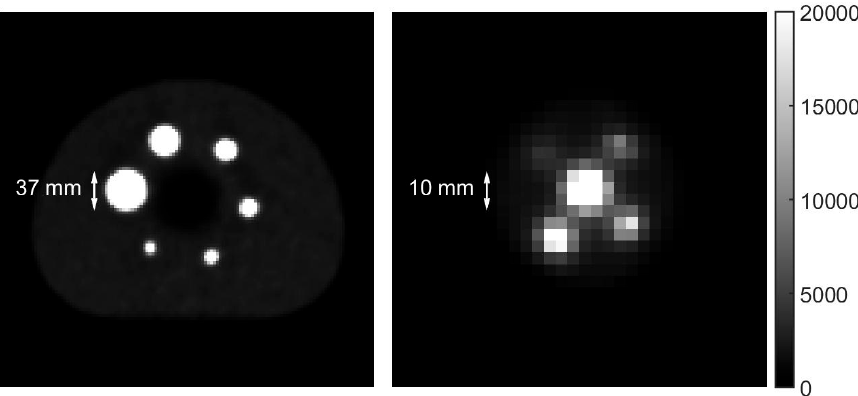
Figure 1. Transverse PET slices of the NEMA IEC Image Quality phantom ( left ) and the Micro Hollow Sphere phantom ( right ). The image of the Micro Hollow Sphere phantom is scaled up by a factor four with respect to that of the NEMA IEC Image Quality phantom to properly show the features. The dimensions of the largest sphere in the Micro Hollow Sphere phantom match with those of the smallest sphere in the NEMA IEC Image Quality phantom. As the voxel dimensions in the transverse plane are 2.73 by 2.73 mm, individual pixels can be clearly distinguished causing a seemingly low image resolution.